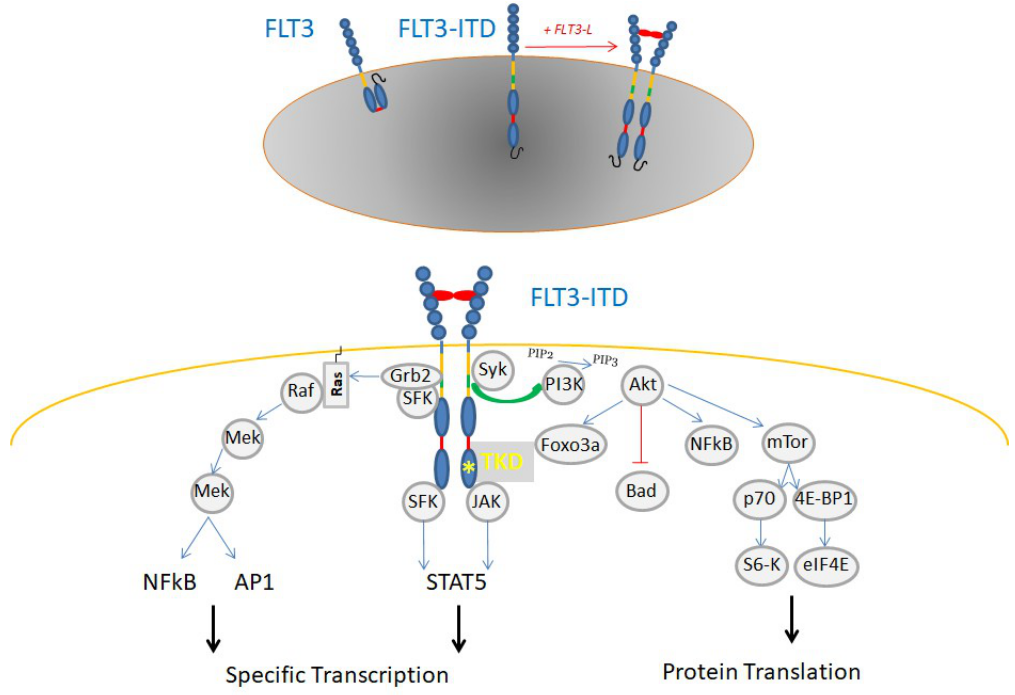
Figure 1. Signaling in AML FLT3-ITD. Like most receptor tyrosine kinases, FLT3 is activated following ligand-induced dimerization and then signals through two major pathways: PI3-kinase/AKT and RAS/RAF/MAP-kinases. Internal tandem duplication by changing structure and localization induces constitutive activation of FLT3 signaling pathway with a large increase in STAT5 activation.